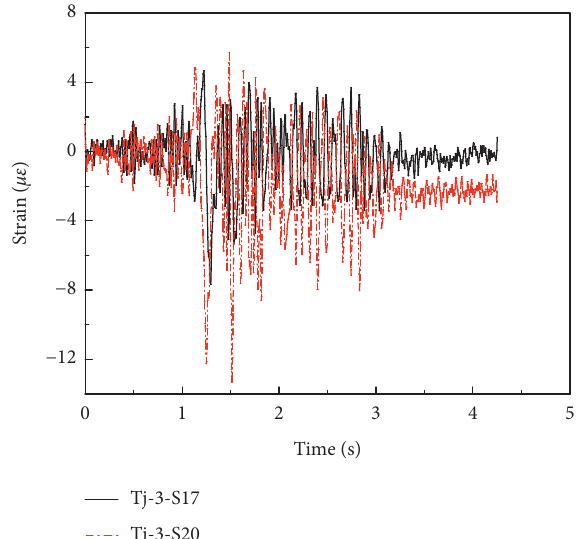
Figure 9: Strain time history of S17 and S20 of the shallow tunnel under the Tianjin wave.